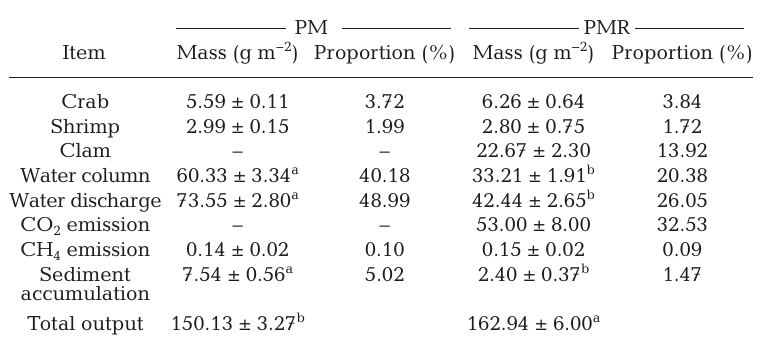
Table 3. Carbon output in the 2 polyculture systems (PM and PMR, defined in Table 1) during the farming season. The values for mass are means ± SD (n = 3) and the values for proportion are presented as means (n = 3). Data in the same row with different superscripts indicate significant differences (p <